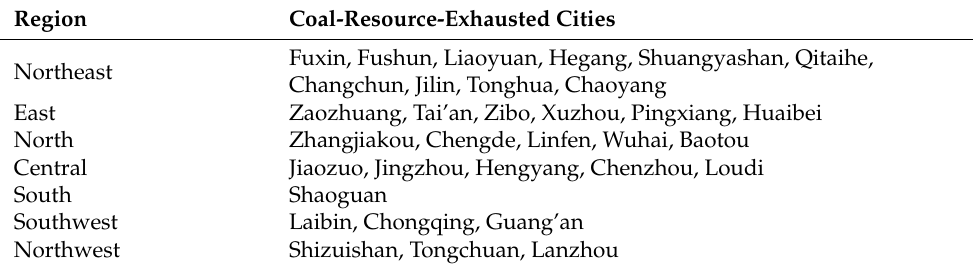
Figure 1. Location and distribution of the object cities. Source: Author self-painting. Table 4. Distribution of coal-resource-exhausted cities in China.